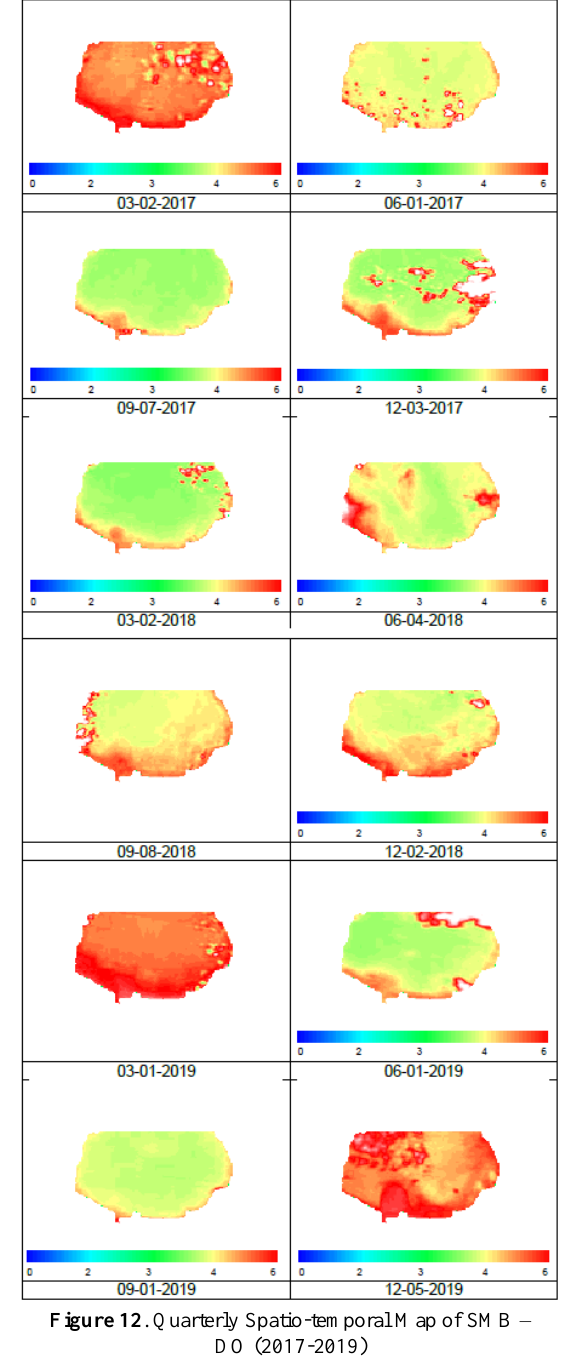
Figure 12 . Quarterly Spatio-temporal Map of SMB